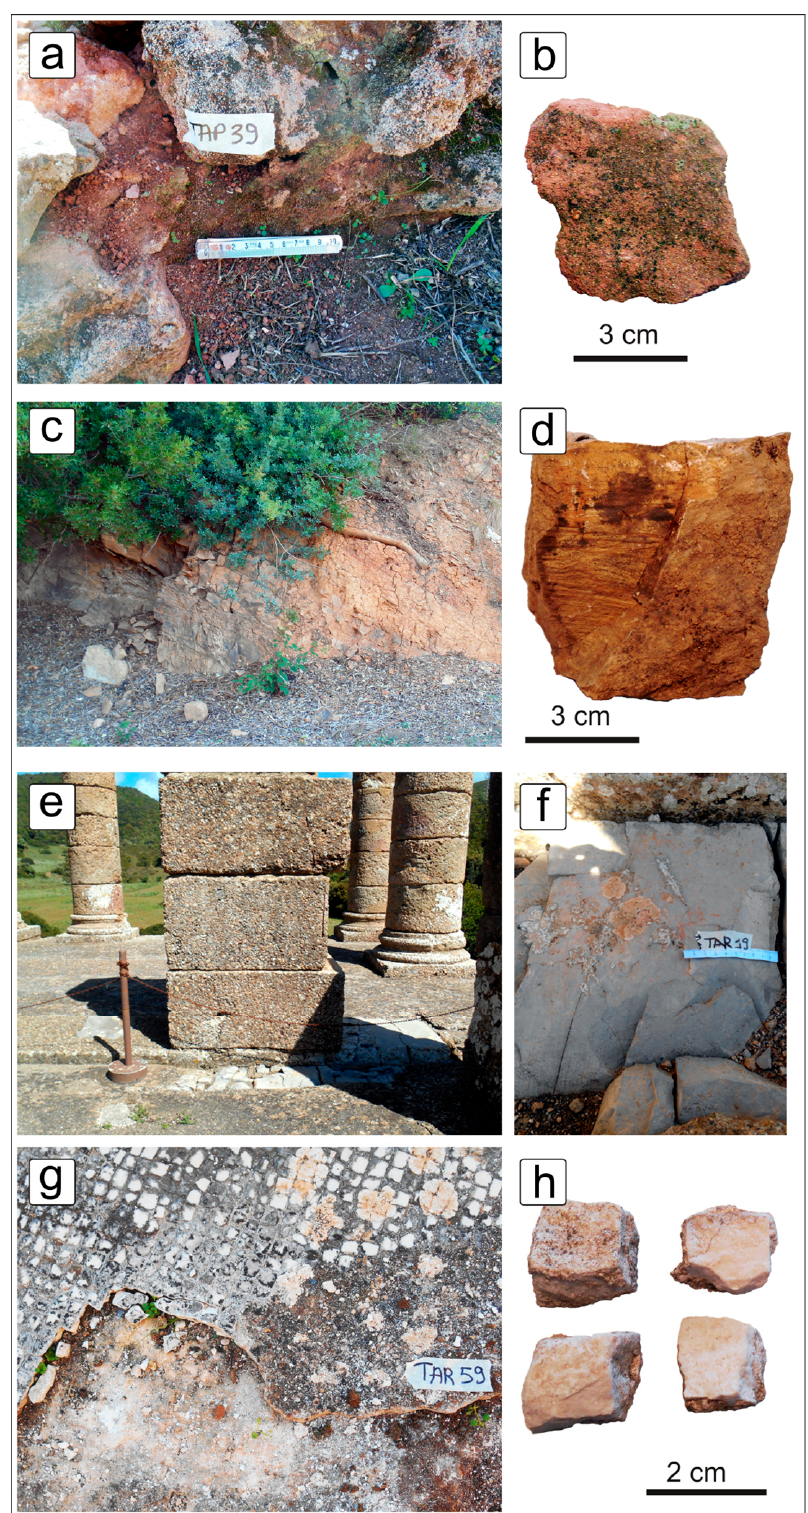
Figure 9. ( a , b ) Sandstone-like rock (“Sandstone” s.l. ) from the Punic temple; ( c , d ) metasiltstone (sample TASC7) collected along the path to the ancient Roman quarries (samples TAC1, TAC2, TAC3); ( e , f ) marly limestone (TAR19) sampled in the Pronao of the Roman temple; ( g , h ) limestone tesserae (sample TAR9) from the mosaic of the Roman temple. Table 1. Sample list summarizes the sampling position of stones and lithology description. “Sandstone” s.l. = “Sandstone” sensu lato.